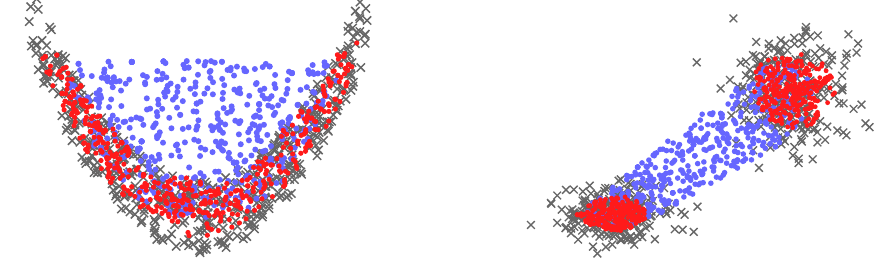
Fig. 3: Two-dimensional data sets (crosses) and corresponding deep points estimated by uniform sampling (blue dots) and stratified sampling with GenDeep (red dots) using the halfspace depth. The datasets were sampled from a non-elliptic banana-shaped distribution (left) and a Gaussian mixture model (right).